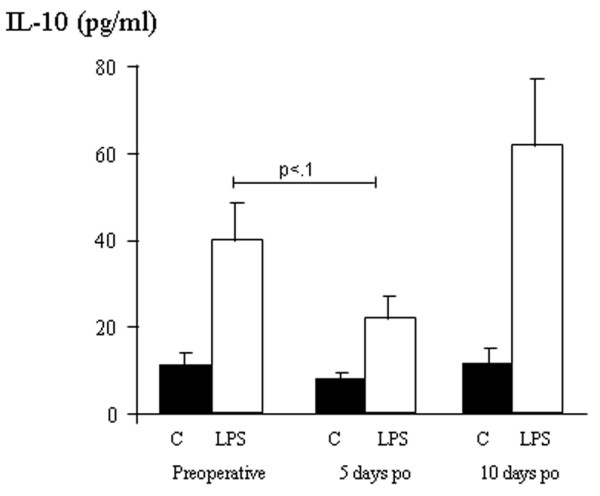
Ex vivo production of interleukin-10. Preoperative and postoperative (po) IL-10 levels in whole blood culture supernatant. Values are expressed as means and SEM (error bars). IL-10 production was significantly increased after stimulation with lipopolysaccharide (LPS; white), in comparison with the control (C; black) at all time points. In comparison with preoperative levels, IL-10 production after stimulation with LPS tended to decrease 5 days after operation but again reached preoperative levels 10 days after operation.